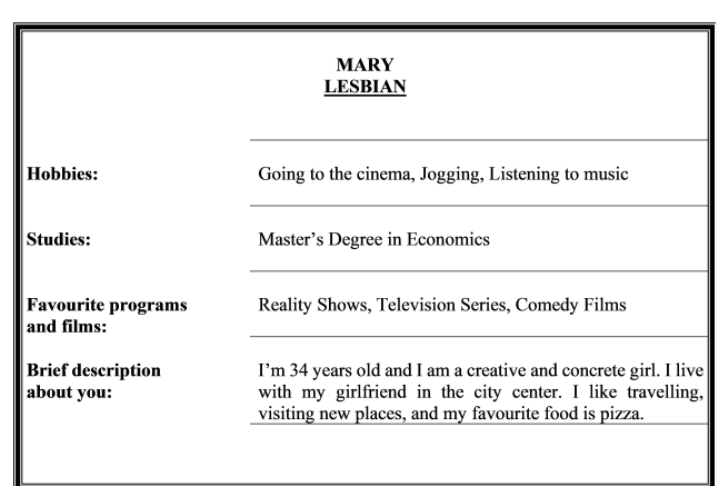
Heterosexual condition Figure A1. Lesbian condition.